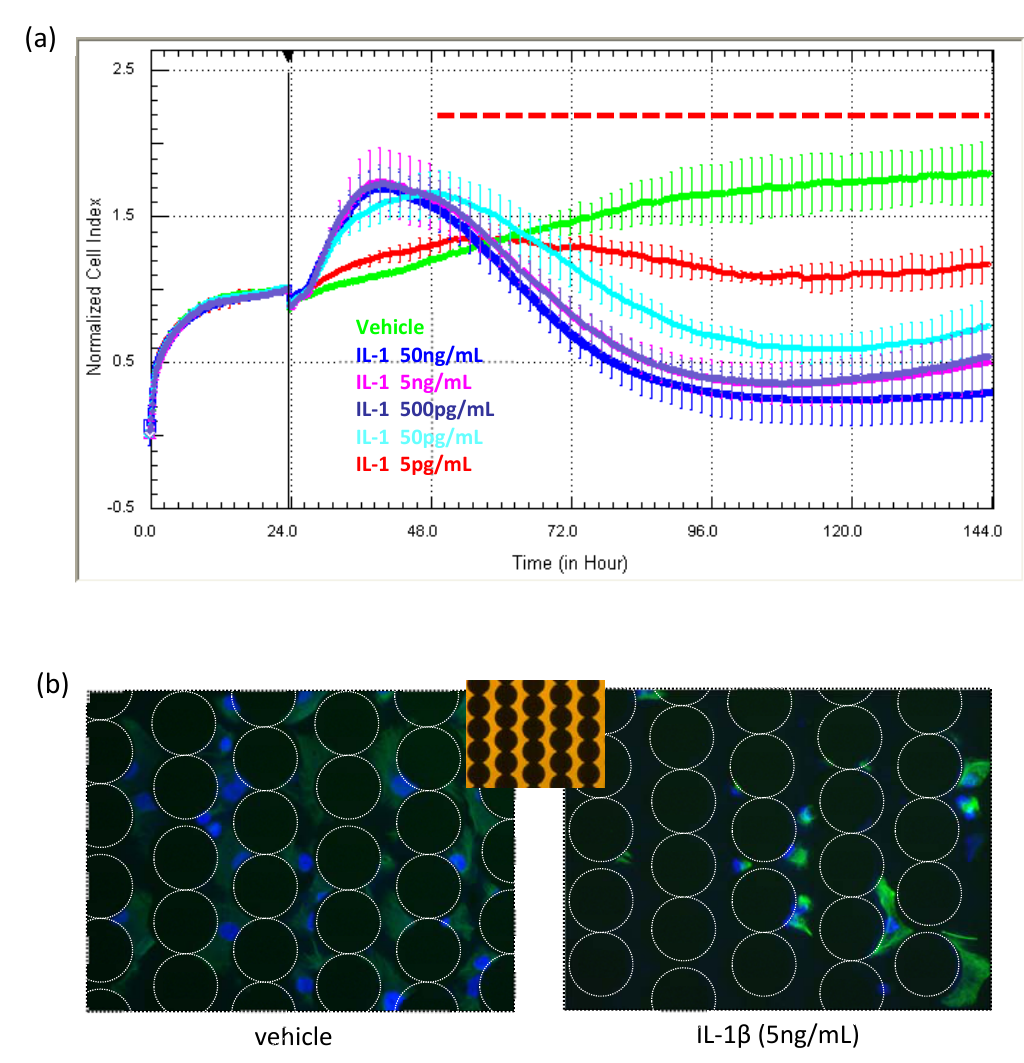
Figure 7. Use of xCELLigence for measuring drug effects on cell viability, compromise and death. Here, NT2 astrocytes were treated with the pro-inflammatory cytokine IL1 β at a range of concentration to assess the acute and long-term effects on the cells. During the initial 24-h period following cytokine treatment, there is a pronounced increase in the Cell Index, which is consistent with inflammatory activation of the cell and increased astrocytic size as a consequence. This is followed by a progressive and continual loss of adhesion. IL1 β was added 24 h after seeding, and each curve represents the mean ± SD of four wells. The images in ( b ) show the viable astrocytes remaining on the E-plate at the end of the experiment. The white dotted circles reveal the position of the non-transparent electrode array. These images were acquired using an inverted microscope. The array can be seen more easily in the bright-field insert. Note that ACEA have developed plates with view strips for imaging of cells during xCELLigence